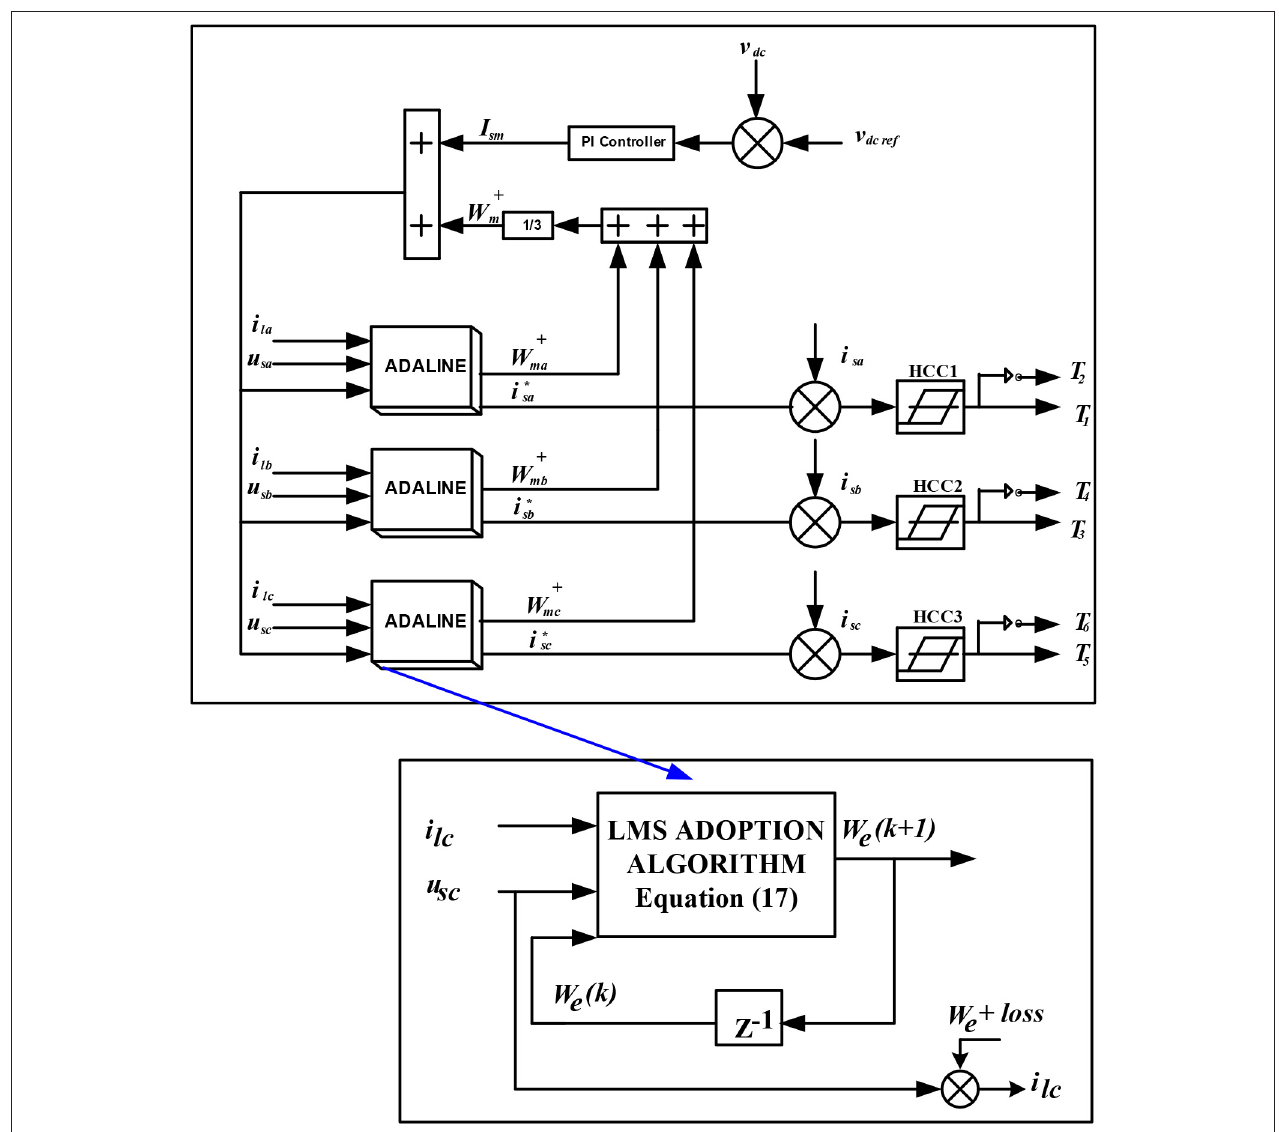
FIGURE 4 | Block diagram of A-LMS